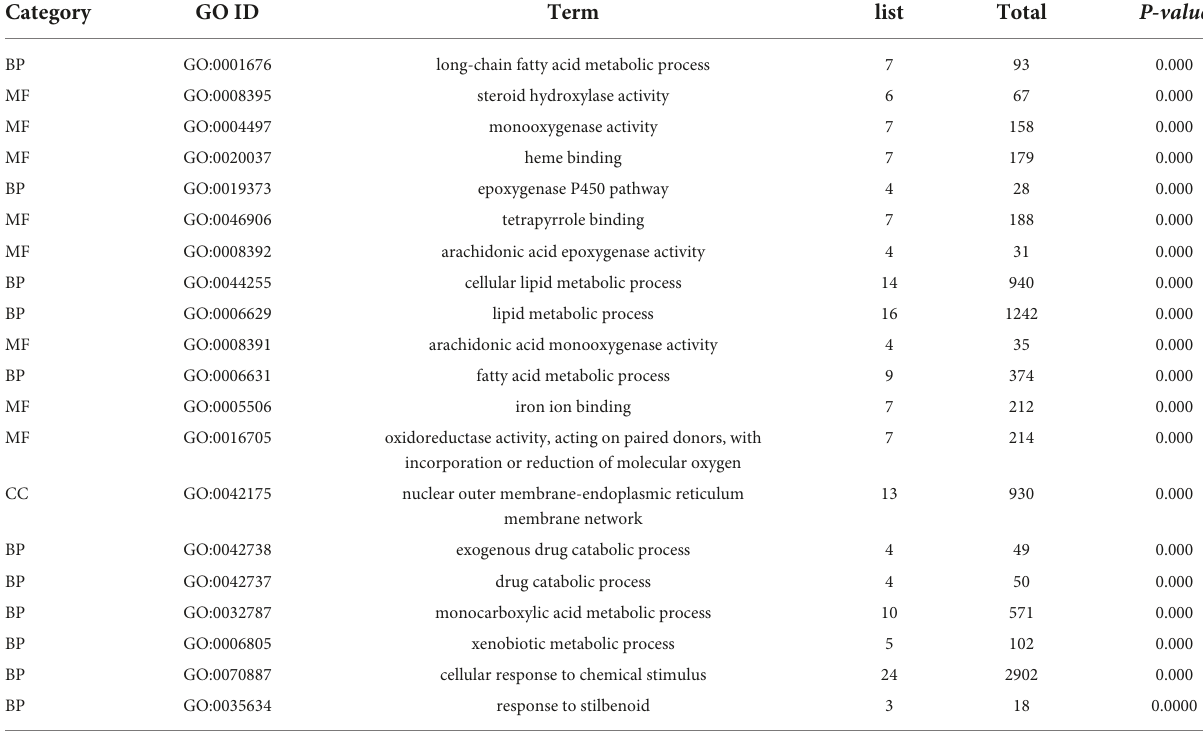
TABLE 5 Top 20 significant GO terms of the overlapped DEGs in